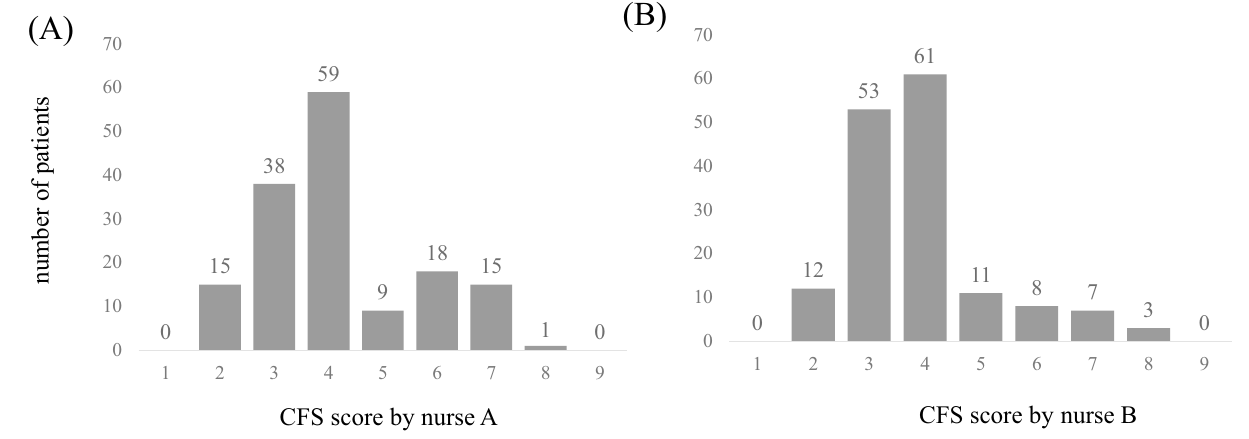
Figure 2. Distribution of CFS scores by two nurses. The category of CFS scores divided by 5 were 86% identical between two